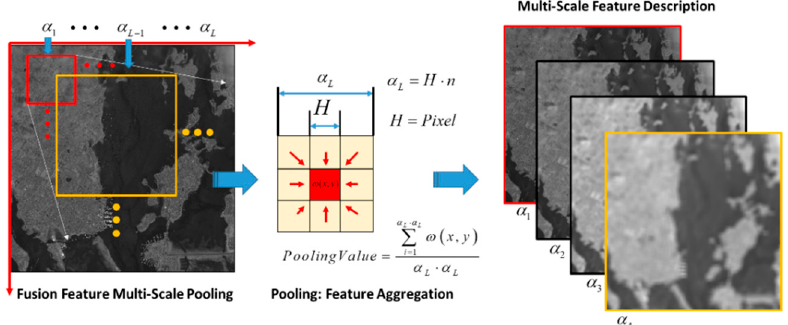
Figure 4. Fusion feature multi-scale pooling process. α L means different scale factors which are the sizes of pooling operation; H represents a pixel in pooling area.